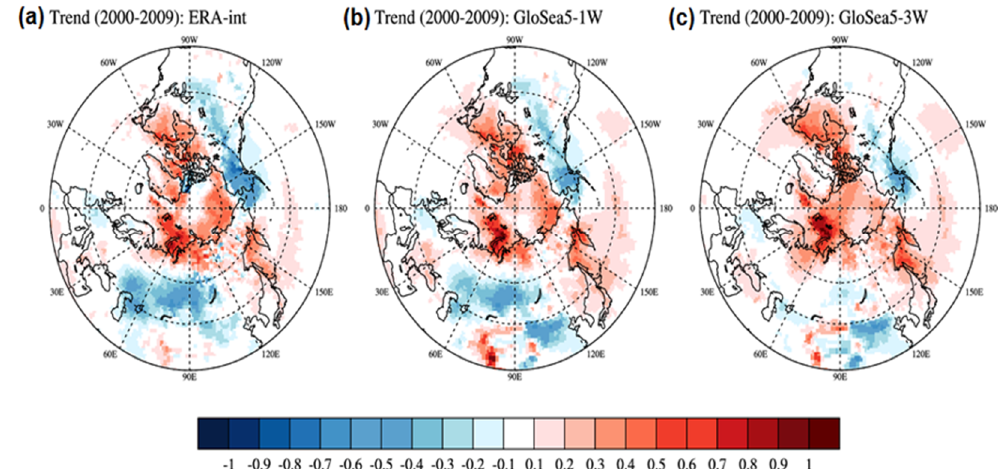
Figure 6. The linear trends in surface temperature during DJF for the period 2000–2009 from ( a ) ERA–Interim and GloSea5 with lead times of ( b ) 1 and ( c ) 3 weeks.